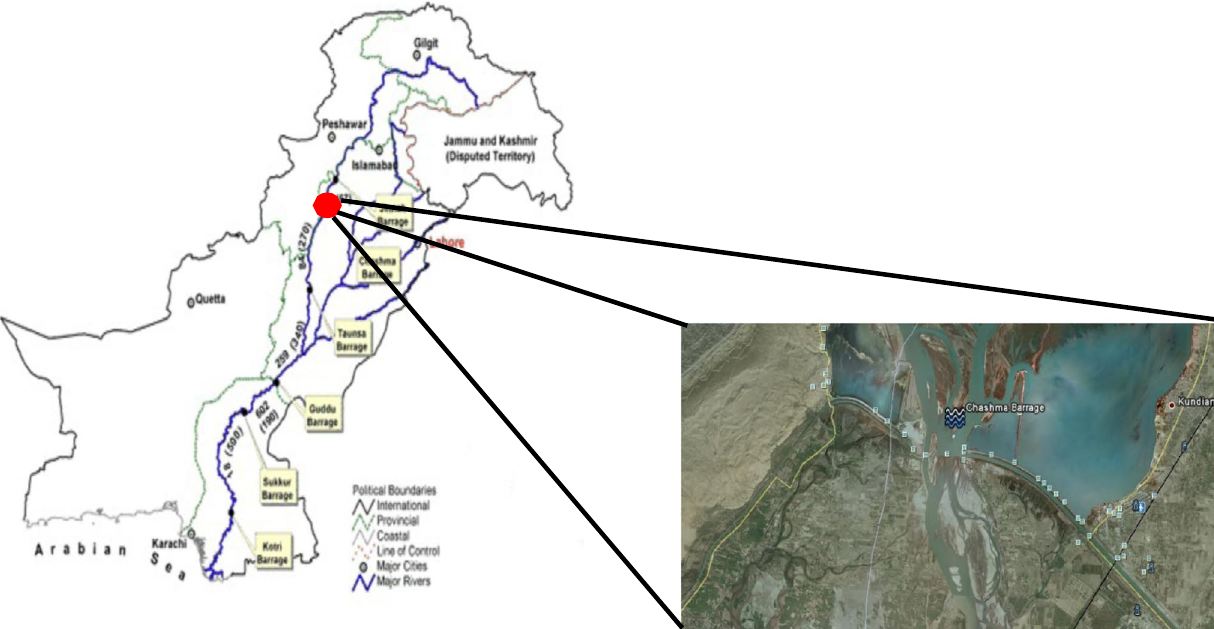
Fig. 1 Location plan of Chashma